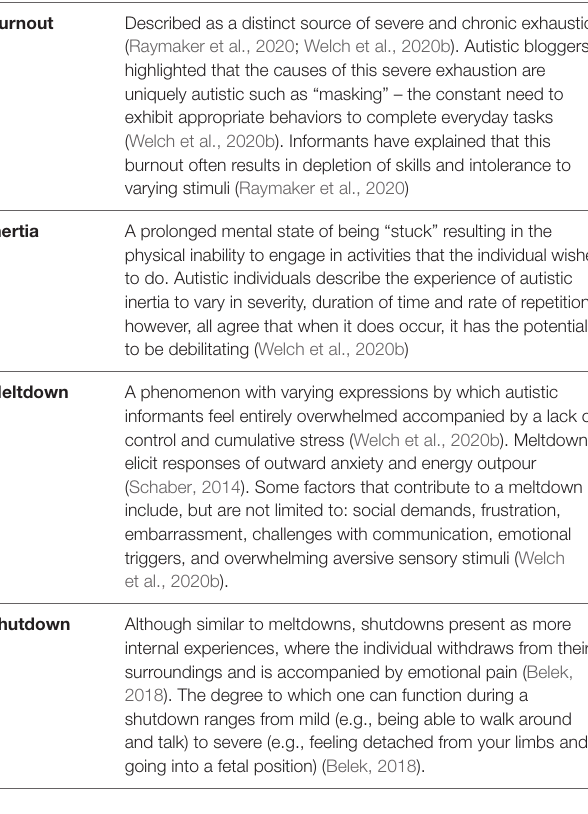
TABLE 1 | Operational definitions of the manifestations of burnout, inertia, meltdown, and shutdown (BIMS) as described by autistic informants of earlier